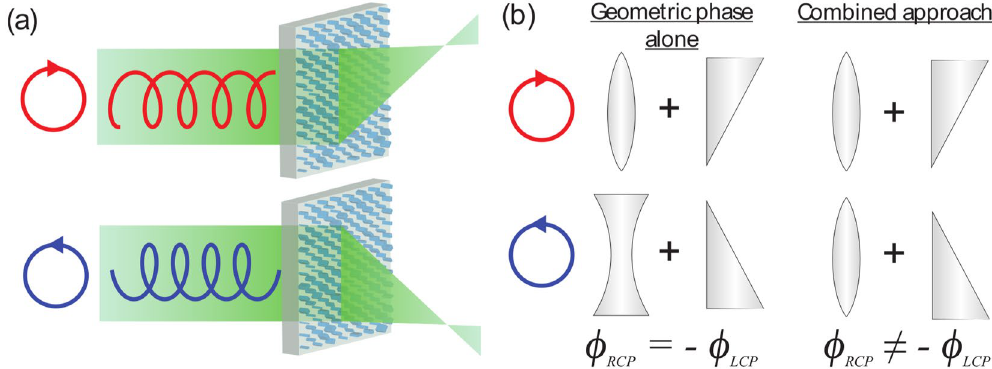
Figure 1. Chiral meta-lens principle. ( a ) Illuminated with LCP or RCP light, the meta-lens focuses an RCP - LCP image on two different positions. ( b ) Analogy demonstrating fundamental design differences with respect to previous chiral-lenses. A geometric phase lens designed for RCP has an equal and opposite phase profile for LCP. It focuses RCP to the right and defocus LCP to the left, here in analogy represented with a refractive lens and a wedge. The combined approach (propagation & geometric phase) allows focusing of LCP and RCP independently from each